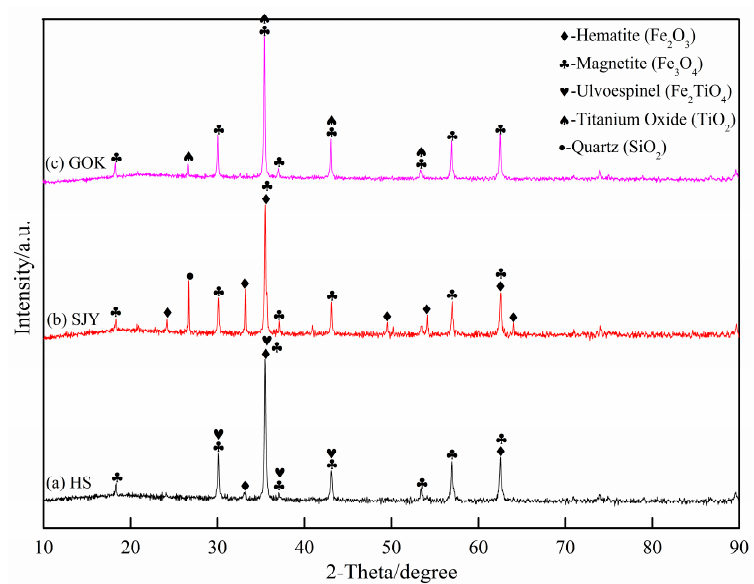
Figure 1. X-ray diffraction analysis pattern of experimental raw materials.